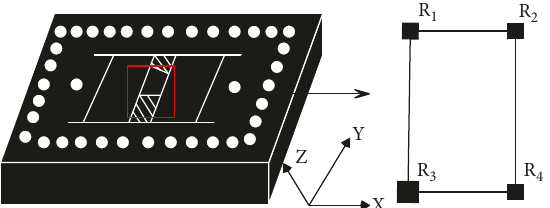
Figure 3: Schematic diagram of the z -axis structure of the ac- celeration